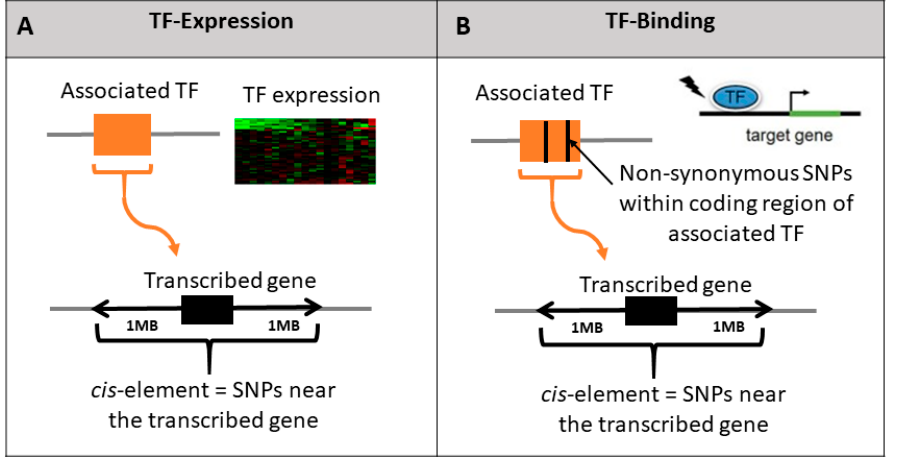
Figure 2. Illustration of the three tested hypotheses regarding the effect of TF genetic polymorphism on the expression of their transcribed genes. We test whether polymorphism in the TF (orange box) affects the transcription levels of the transcribed gene (black box) by testing the added effect of each TF model relative to the baseline cis model. TF-expression model includes association of the TF expression with imputed gene expression ( A ); TF-binding model includes non-synonymous SNPs within the associated TF boundary ( B